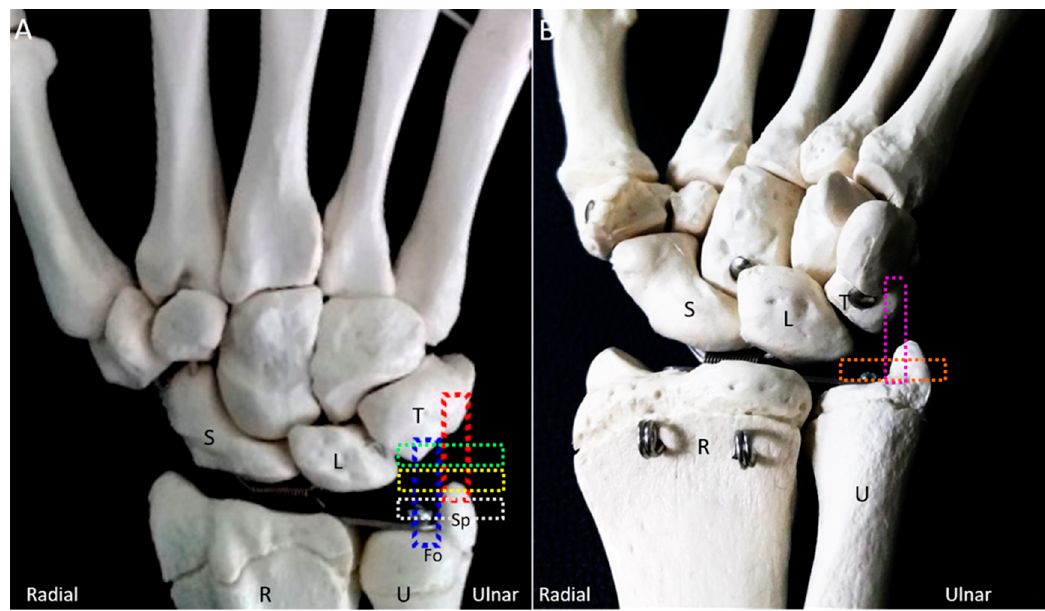
Figure 3. The colored dashed rectangles indicate the transducer positions on the ( A ) dorsal and ( B ) ventral aspects of the wrist for scanning the triangular fibrocartilage complex. U: ulna; R: radius; L: lunate; T: triquetrum; S: scaphoid; SP: styloid process; Fo: fovea.